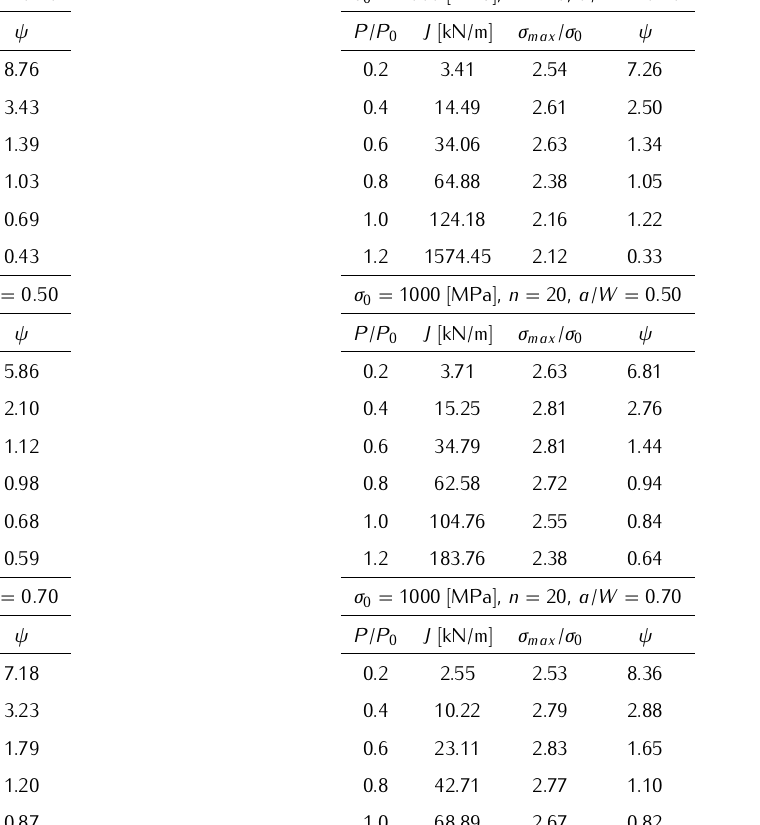
Table C3. NumericalresultsforCC(T)specimenscharacterized by yield stress σ MPa and work hardening 0 = 1000 exponent in R-O relationship n = 10 σ n = 10, a/W = 0 . 20 0 = 1000 [MPa],